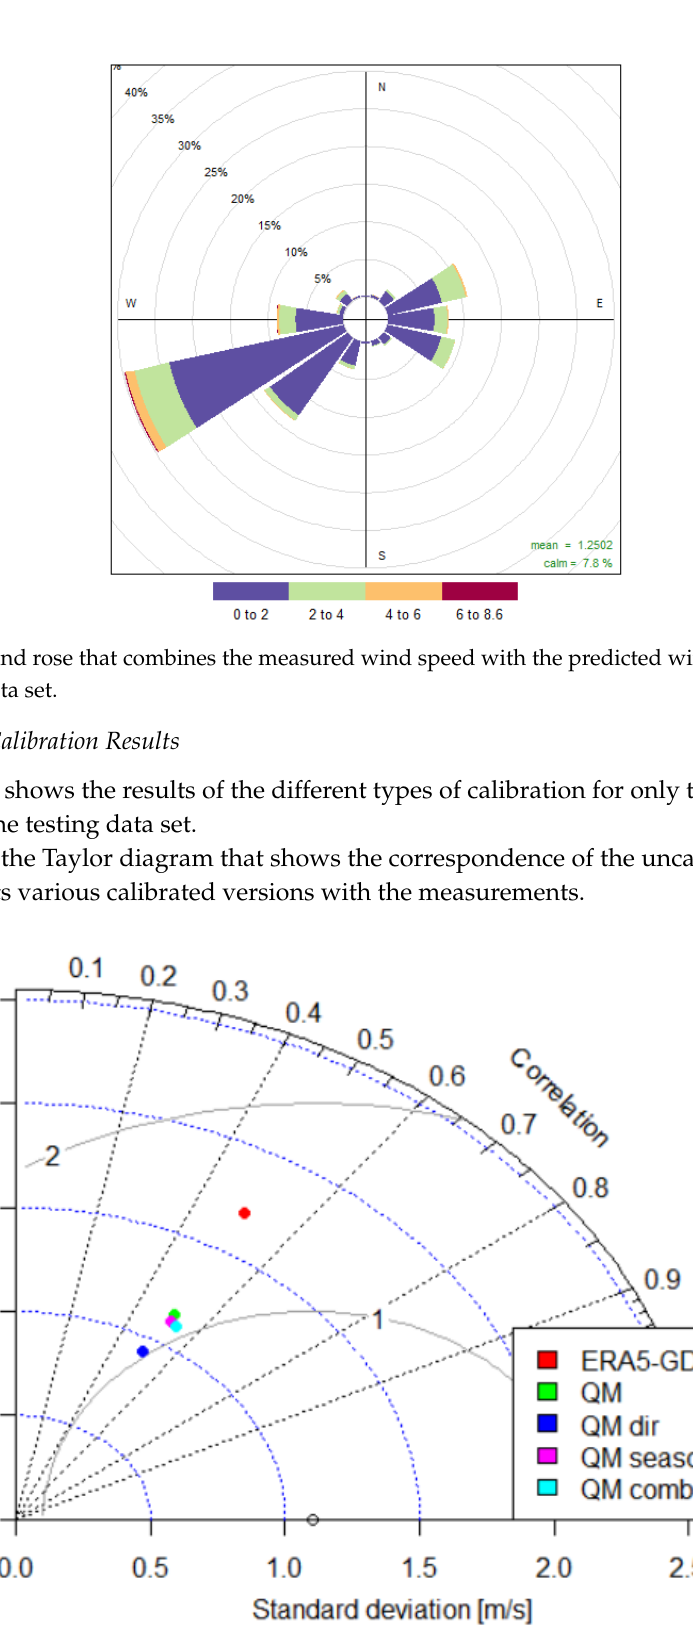
Figure 14. Taylor diagram of the various calibrations and the uncalibrated wind speed time series from the closest grid point against the